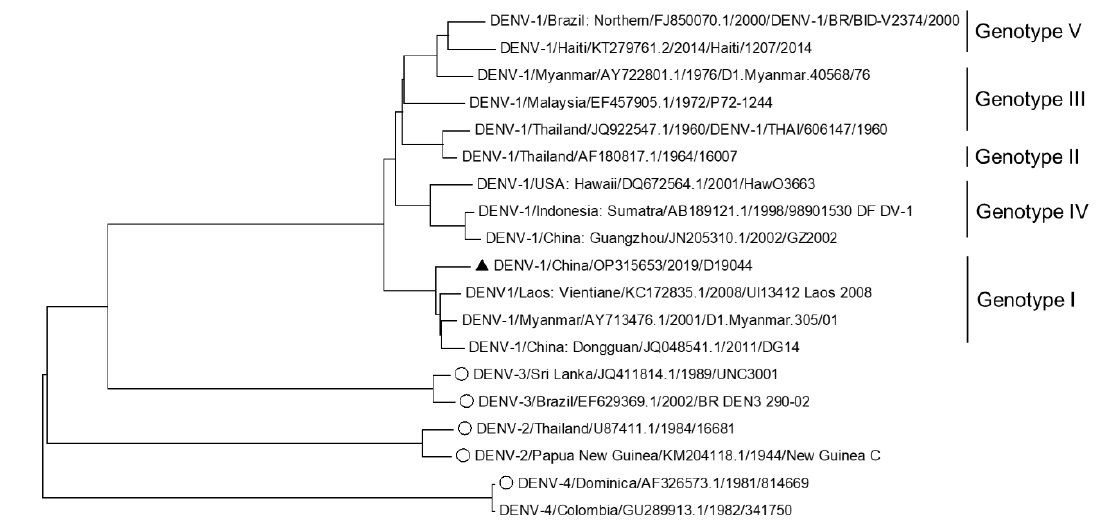
Figure 1. Phylogenetic analysis of D19044 and other DENV isolates. The isolates of genotypes I-V DENV-1 with complete genome sequences available from GenBank were selected to make phylogenetic analysis. Of DENV-2, -3, and -4, two sequences representative of each serotype were selected, especially for those with infectious clones developed. The phylogenetic tree is made based on the ORF nucleotide sequences using neighbor-joining method. A solid triangle ( ▲ ) highlights the D19044 isolate of this study. A circle ( ○ ) indicates that the infectious clone of the isolate has been developed.